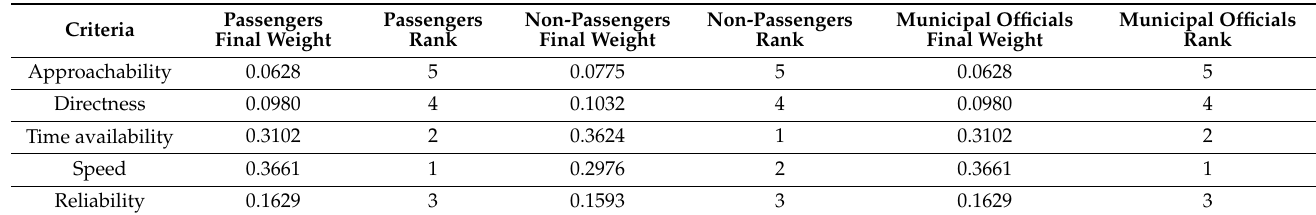
Table 3. Stakeholders final weight score for level 1.